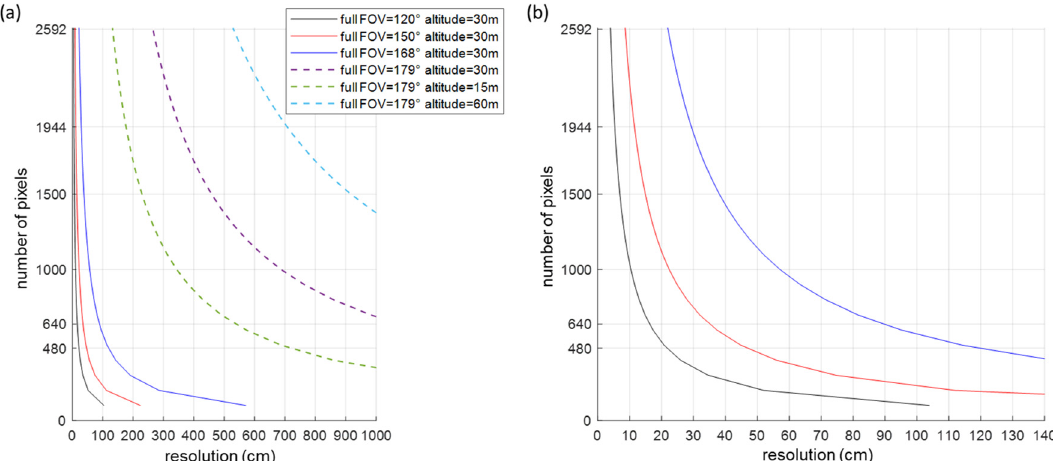
Figure 2. Required number of pixels as function of the resolution, for different FOV and working distances: ( a ) a full FOV from 120° up to 179°; ( b ) a closeup of ( a ) focusing on the small resolution values between 0 cm and 140 cm, for full FOV of 120°, 150° and 168°. A steep increase of the number of pixels can be observed with improved resolution.